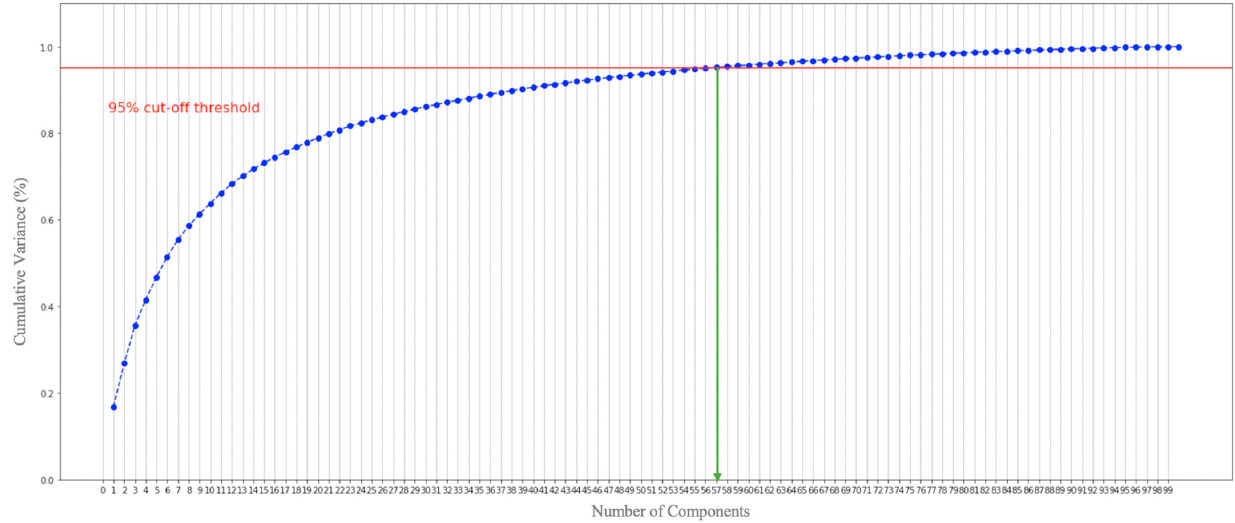
Figure 10. The number of components needed to explain the